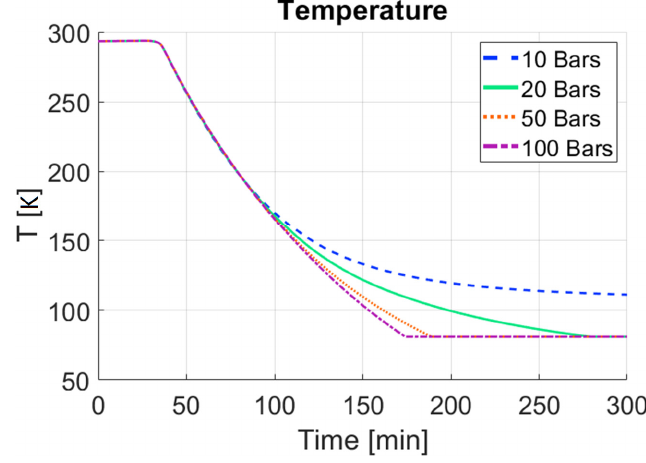
Figure 17. Cooling characteristic of the model prototype at expander outlet.